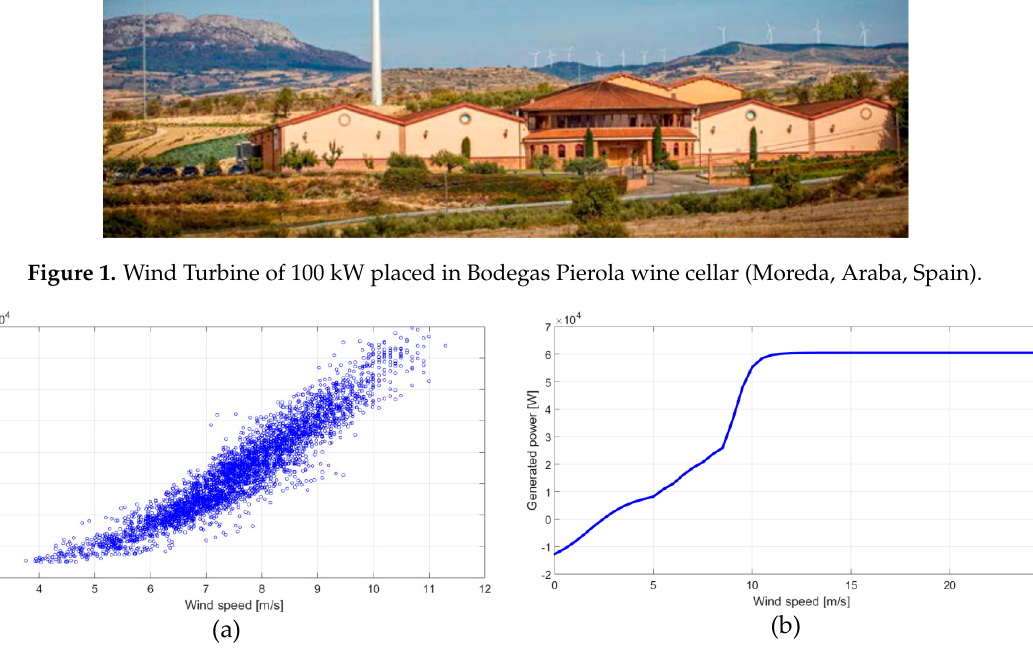
Figure 2. ( a ) Generated power (W)—Wind speed (m/s) real measurements of the wind turbine; ( b ) Generated power curve of the wind turbine.